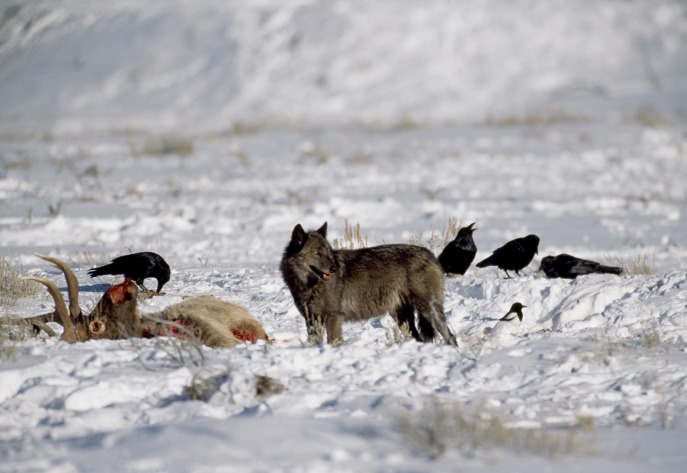
Reintroduced wolves do their part: an intact food chain buffers the impact of deteriorating environmental conditions (Photo: Dan Hartman)